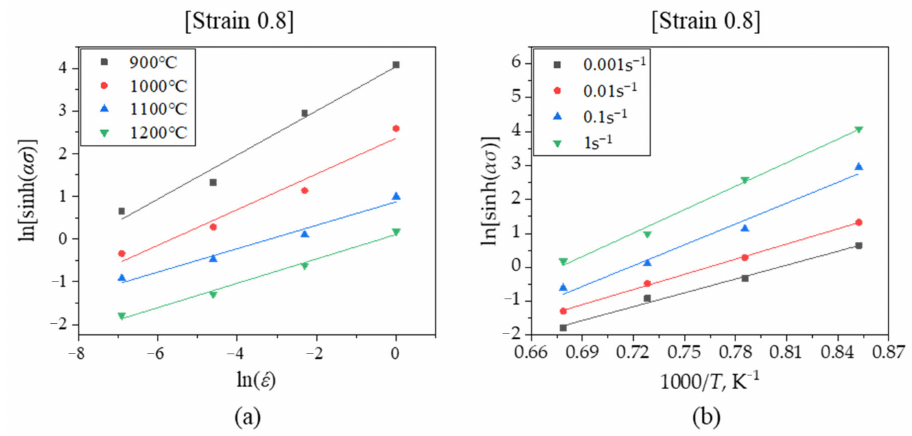
. ε and ( b ) T p by plotting